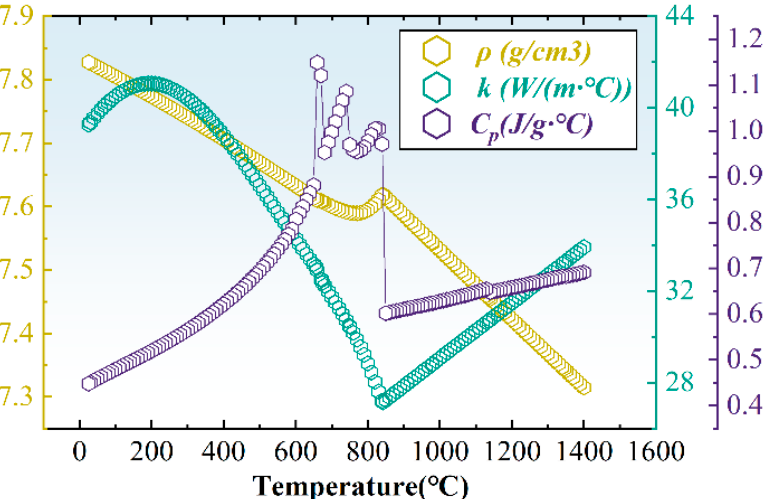
Table 6. Heat source and material property parameters.